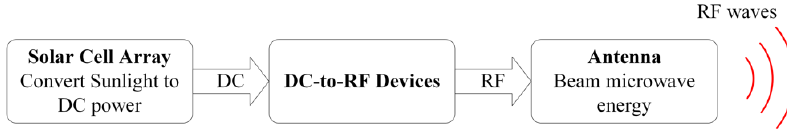
Figure 2. Basic structure schematic diagram of wireless power transmission (WPT) via microwave radiation.